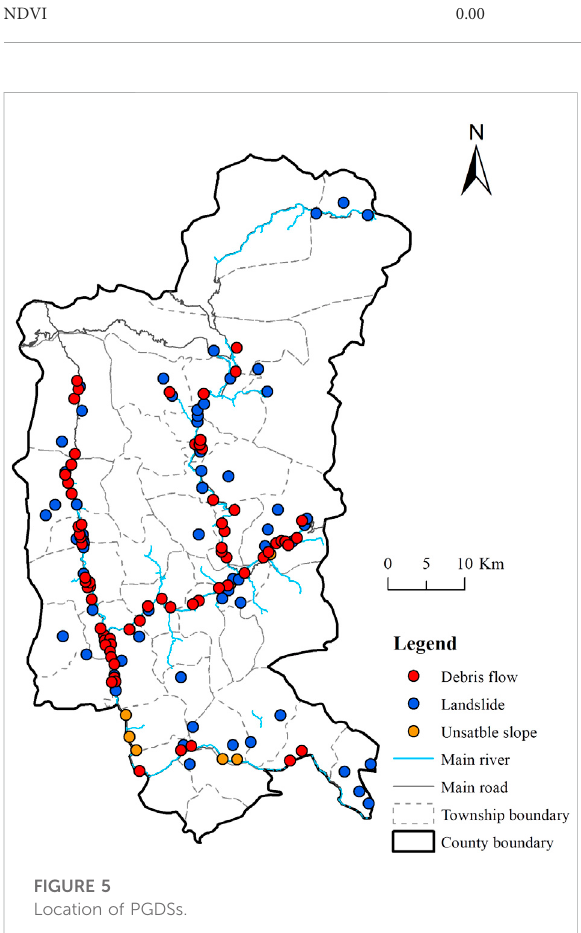
FIGURE 6 SDE distribution of